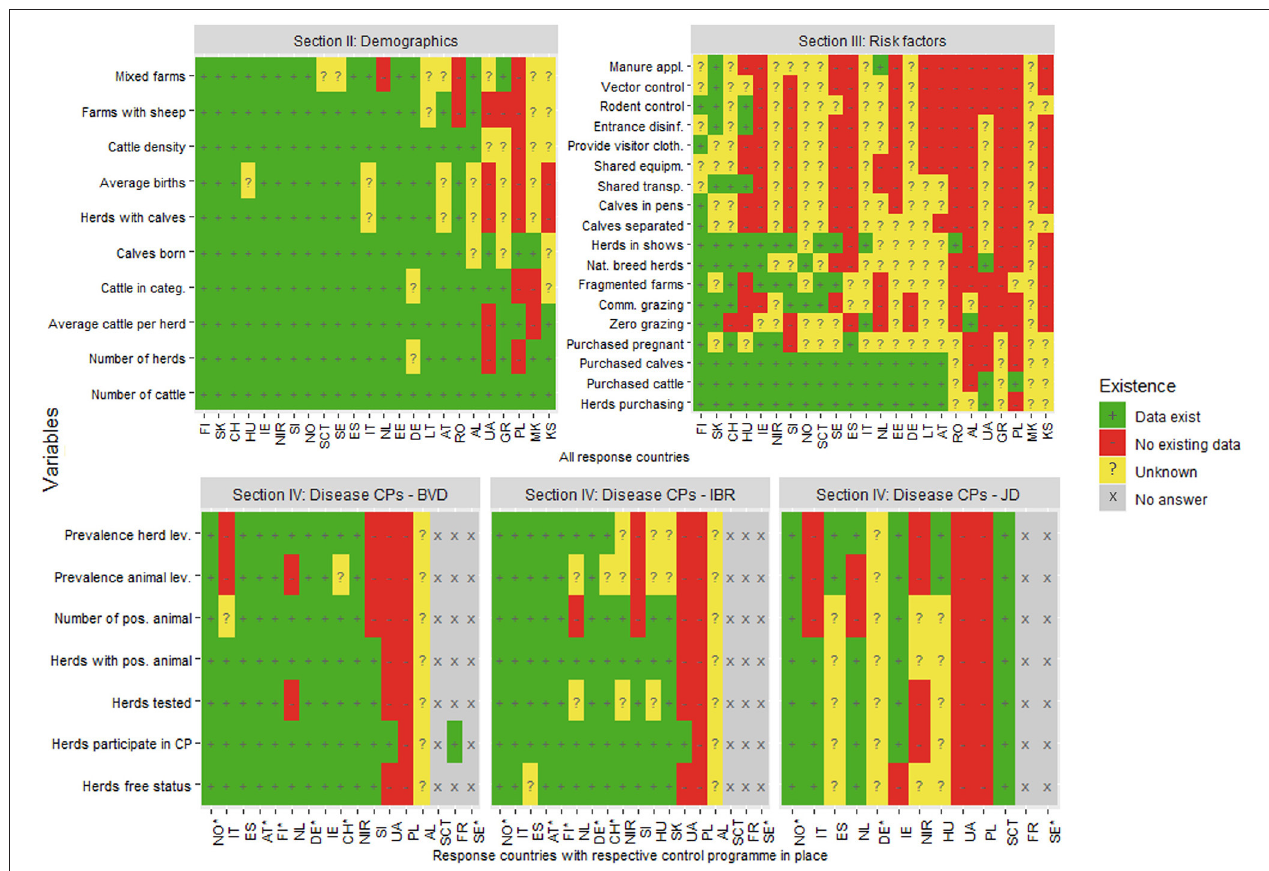
FIGURE 3 | The existence of data relevant for estimating probability of freedom from infection in cattle in an online questionnaire study among 24 European countries. The answers are presented by country and variable. *free from disease status. FI, Finland; SK, Slovakia; CH, Switzerland; HU, Hungary; IE, Ireland; NIR, Northern Ireland (UK); SI, Slovenia; NO, Norway; SCT, Scotland (UK); SE, Sweden; ES, Spain; IT, Italy; NL, Netherlands; EE, Estonia; DE, Germany; LT, Lithuania; AT, Austria; RO, Romania; AL, Albania; UA, Ukraine; GR, Greece; PL, Poland; MK, North Macedonia; KS,